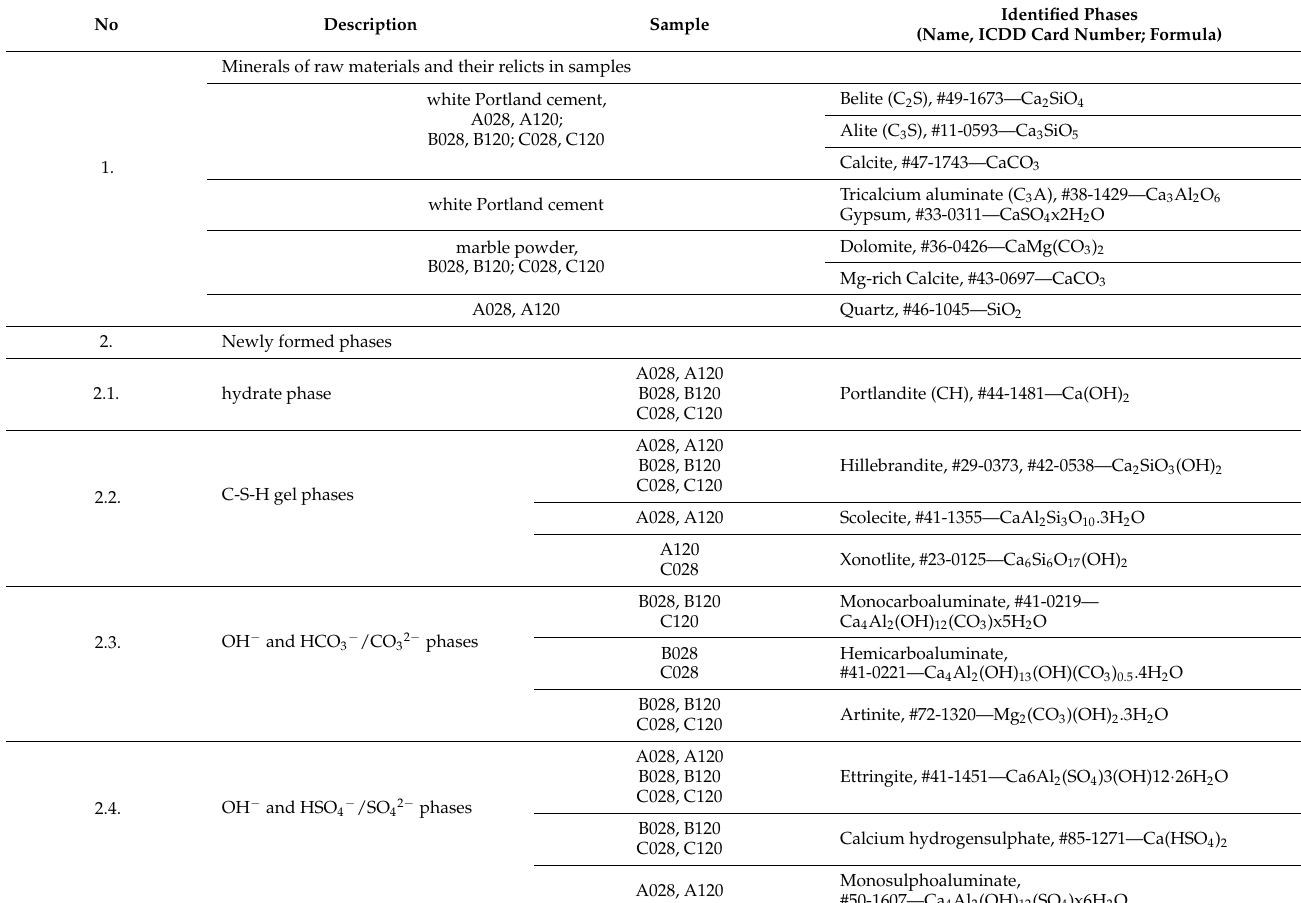
Table 3. Results from PXRD analysis of raw materials (white Portland cement, marble powder, and sand) and A028, A120, B028, B120, C028, and